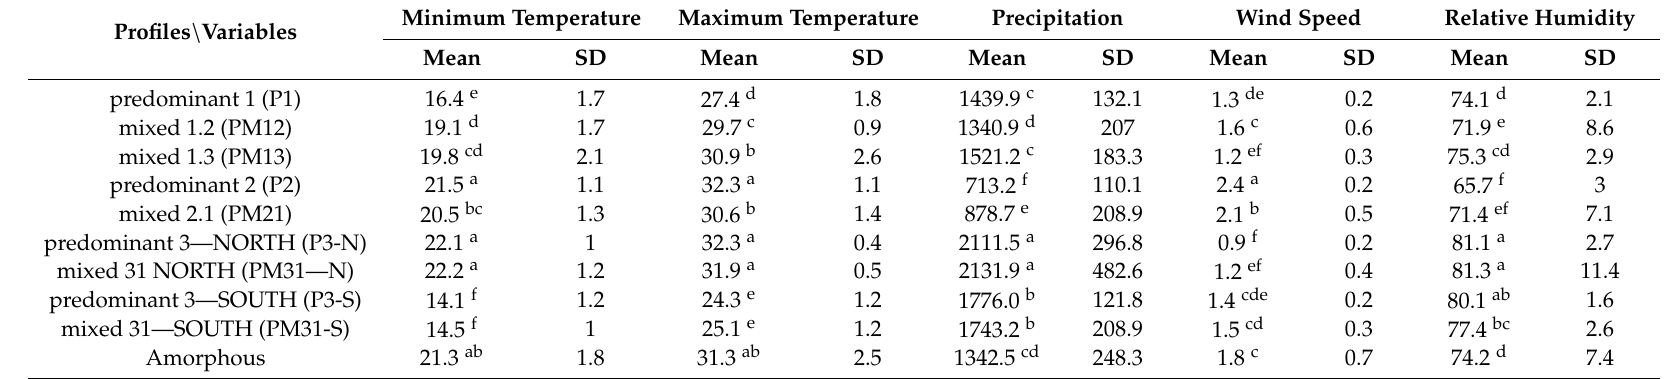
Table 3. Descriptive statistics of the predominant and mixed profiles built for the Brazilian microregions, according to the meteorological variables. Profiles \